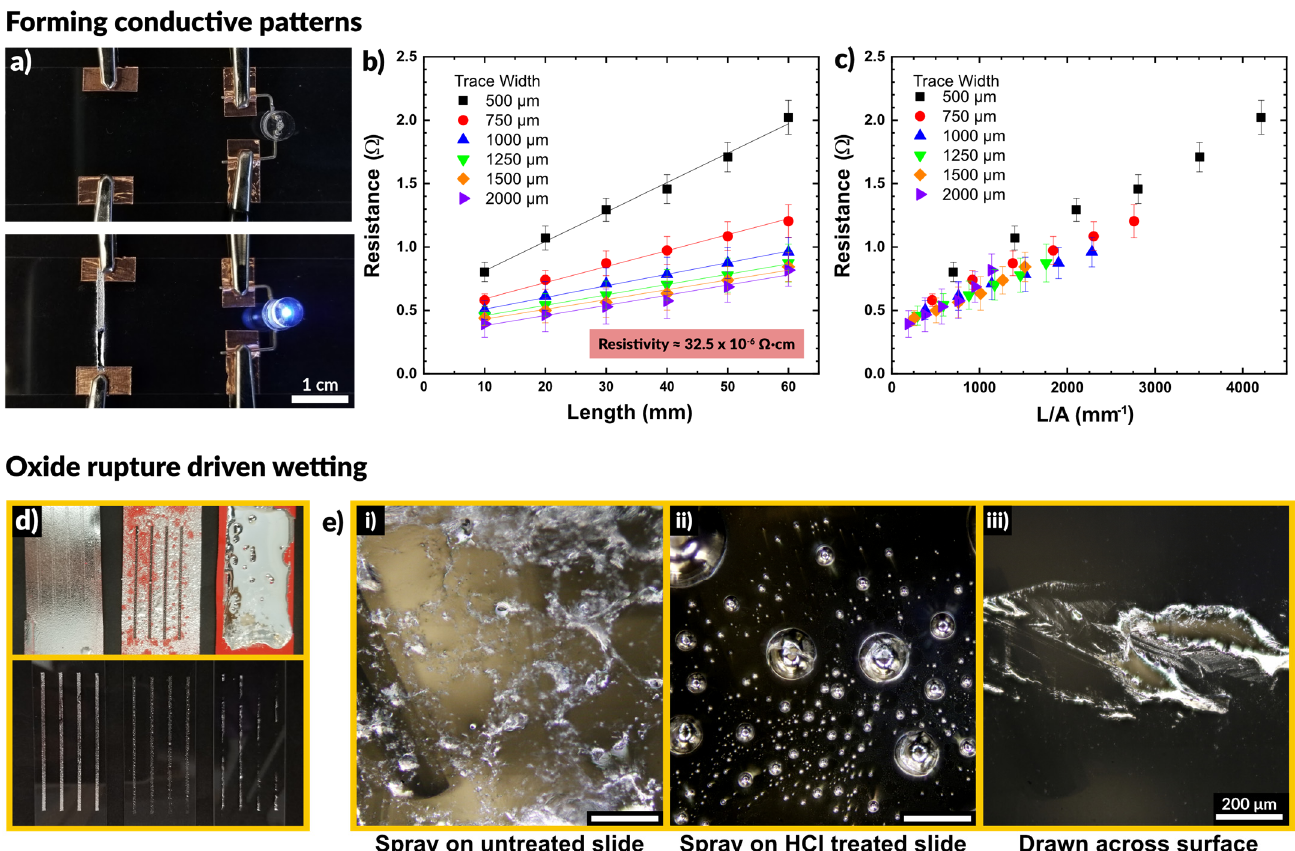
Figure 2. ( a ) A sprayed line of metal connects a circuit to power an LED, demonstrating that sprayed traces are immediately conductive without post-processing. ( b , c ) Plots of resistance as a function of trace length and trace width. Resistivity is calculated by determining a line of best fit and using Pouillet’s law. ( d , e ) A comparison of depositing liquid metal through stencils by spraying on an untreated glass slide, spraying on an HCl treated slide, and drawing liquid metal across the surface. The spray coated sample is uniformly covered, while the HCl treated slide show disconnected droplets and the drawn sample shows non-uniform wetting over the surface.